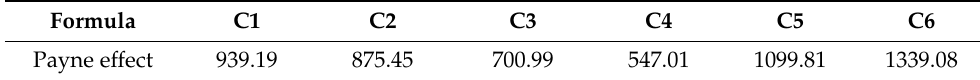
Figure 7. Stress–strain curves of GF/rubber composites with different ratios. Table 5. Payne effect.